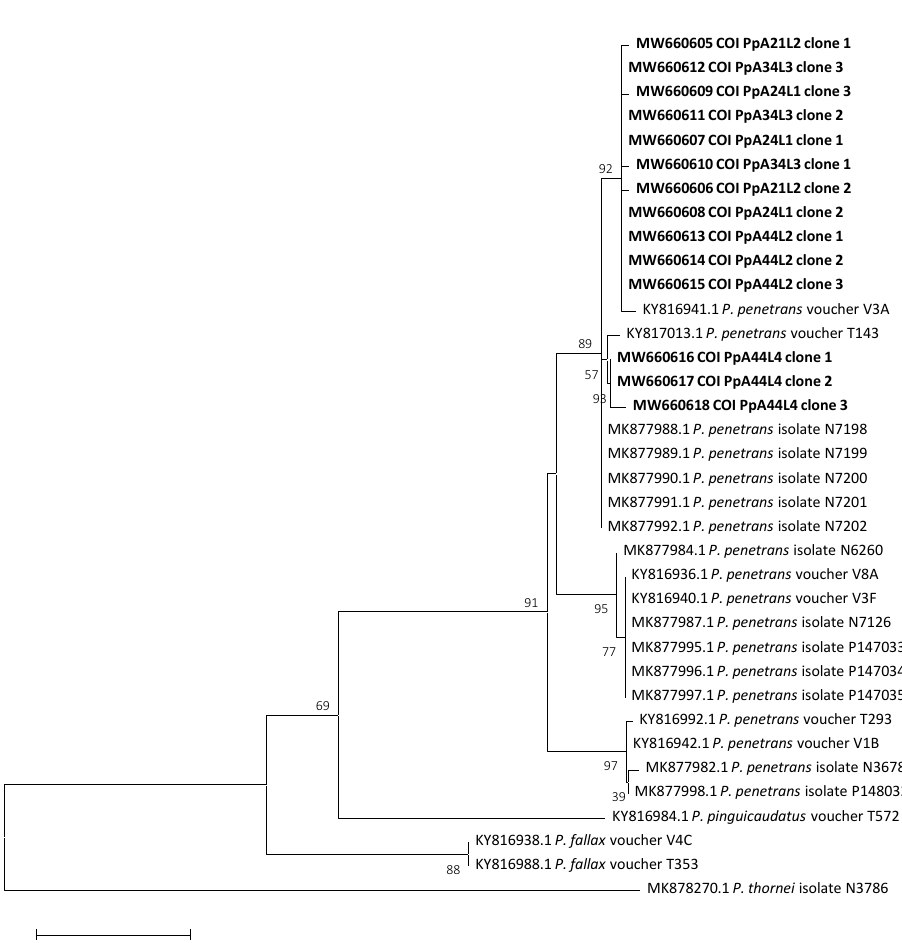
Figure 3. Neighbor-joining phylogenetic tree based on COI nucleotide sequences of Pratylenchus penetrans , P. pinguicaudatus and P. fallax . COI sequence from P. thornei was used as the outgroup. Bootstrap values are shown next to the branches and values with less than 50% confidence are not shown. Scale bar represents nucleotide substitutions per